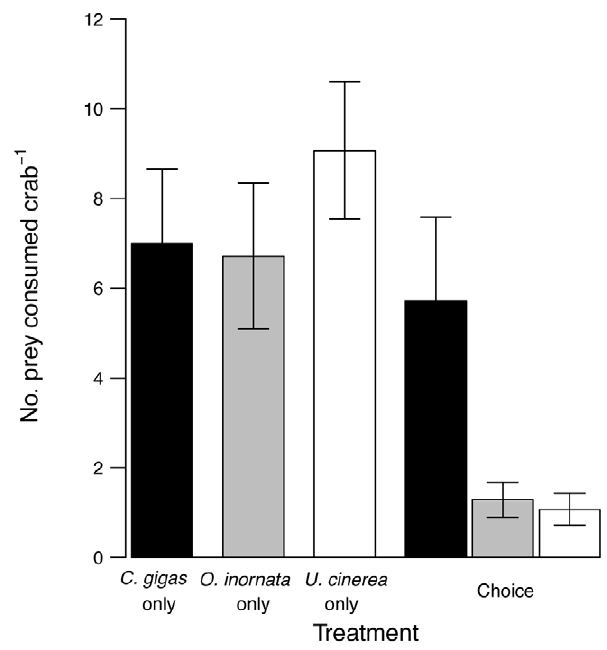
Figure 3. Crab feeding rates and preference on oyster drills and Crassostreagigas. Number (mean 6 SE) of prey consumed by crabs over 24 hours in the drill/oyster preference experiment. Black bars are Crassostrea gigas , Pacific oysters, gray bars are Ocenebra inornata , Japanese drills, and white bars are Urosalpinx cinerea , Atlantic drills. Crabs were randomly assigned to one of four treatments (n=14): (1) 25 C. gigas only, (2) 25 Ocenebra inornata only, (3) 25 Urosalpinx cinerea only, or (4) the treatment labeled ‘‘Choice’’, 25 C. gigas , 25 O. inornata , and 25 U. cinerea .